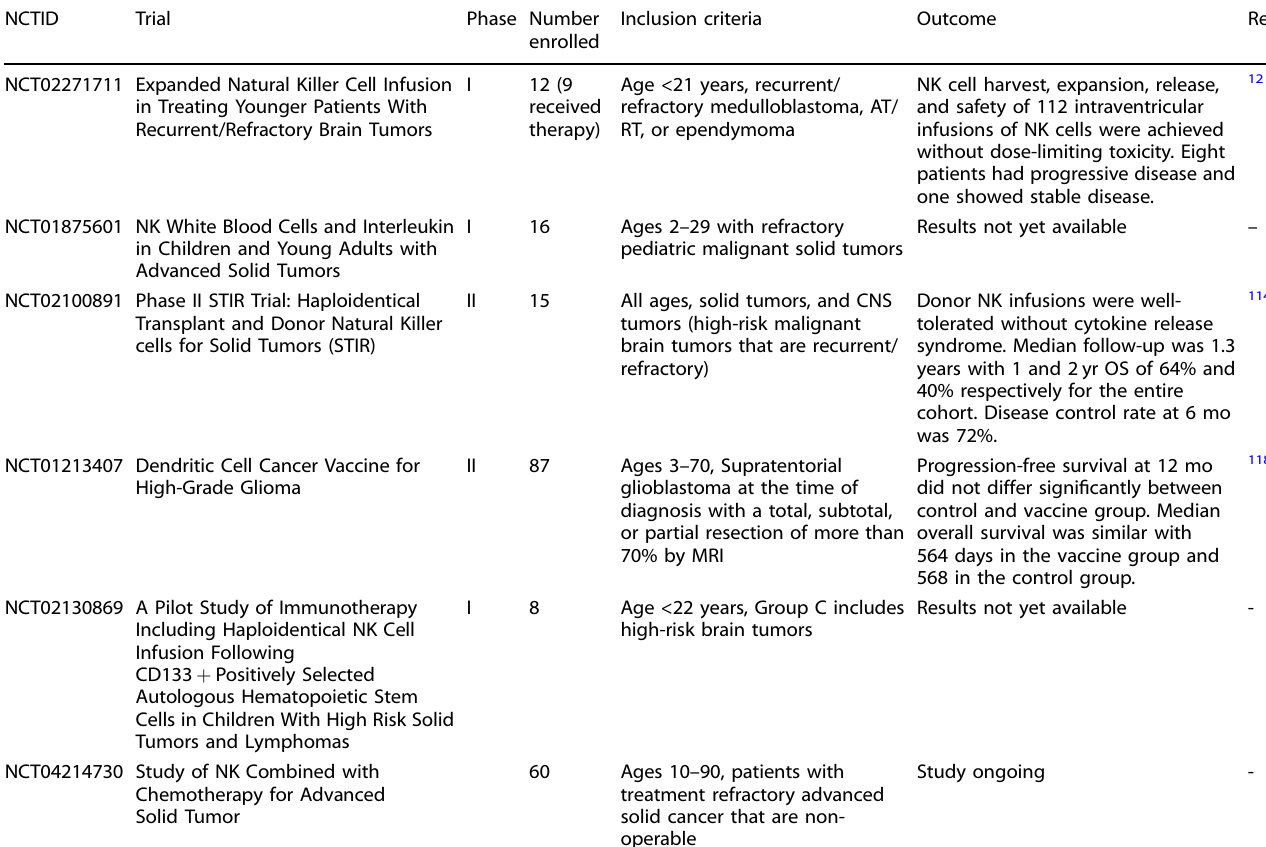
Table 4. Clinical trials using NK cell therapies for pediatric brain